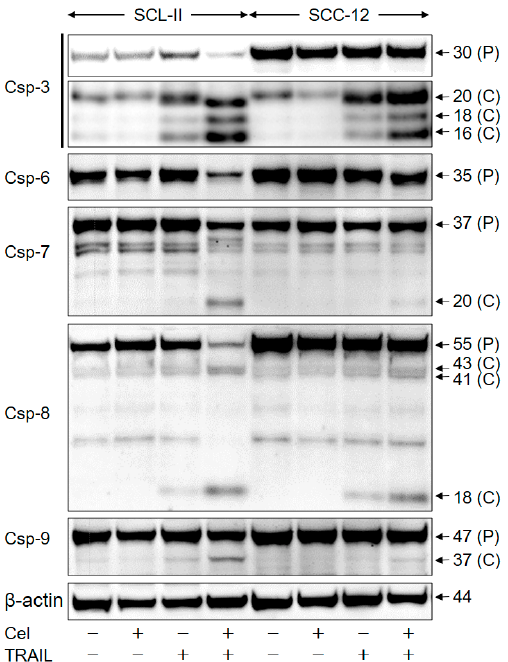
Figure 5. Enhanced caspase activation in the course of combination treatment. SCL-II and SCC-12 cells were treated for 24 h with celecoxib (50 µM) and/or TRAIL (50 ng/mL). Protein extracts were analyzed by Western blotting for expression of caspase-3, caspase-6, caspase-7, caspase-8 and caspase-9. Equal protein amounts (30 µg per lane) were separated by SDS-PAGE, and consistent blotting was proven by Ponceau staining as well as by evaluation of expression of β -actin. Proforms (P) as well as caspase cleavage products (C) were identified. Two independent series of protein extracts and independent Western blots revealed highly comparable results.